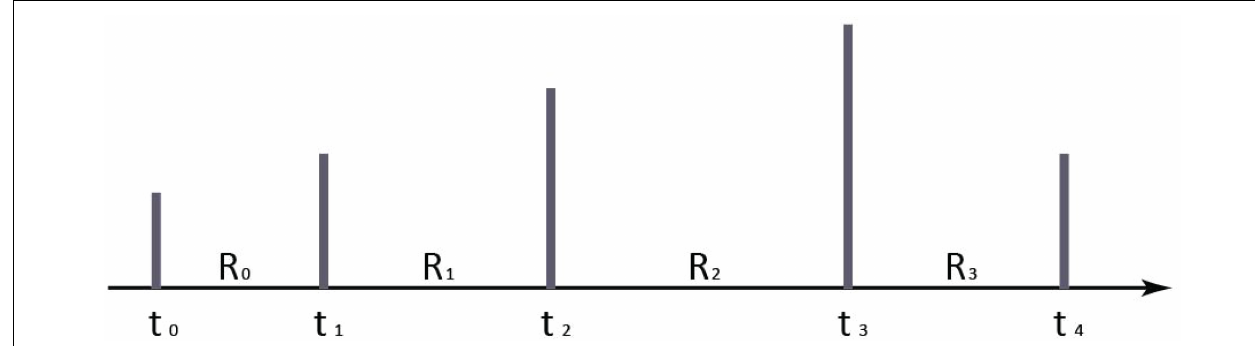
FIGURE 2 | Simplified mental